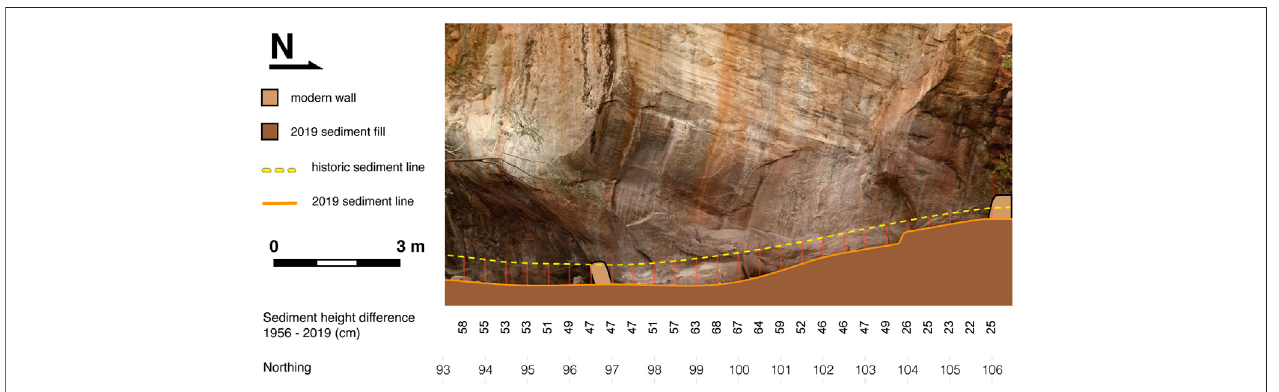
FIGURE 9 | Orthomosaic of the back wall of the shelter with outlines of modern and 1956 sediment lines, the volume outline of rock slabs, and the modern containment wall. The difference in the Z directionbetweenthe historic and modern sediment lineisshown at positions spaced 50 cmapart alongthesite grid. Note the difference inelevation betweenthelowersouth portion and highernorthernedgeprobably duetothehigher impact ofcolluvialinputversuserosionbecauseoftheslabs and the northern boulder that protect this area.